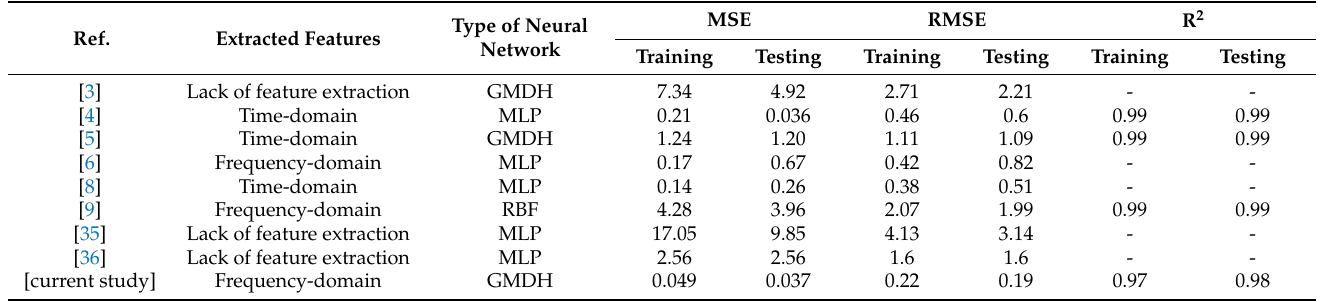
Table 1. A comparison of the accuracy between the present and former studies.